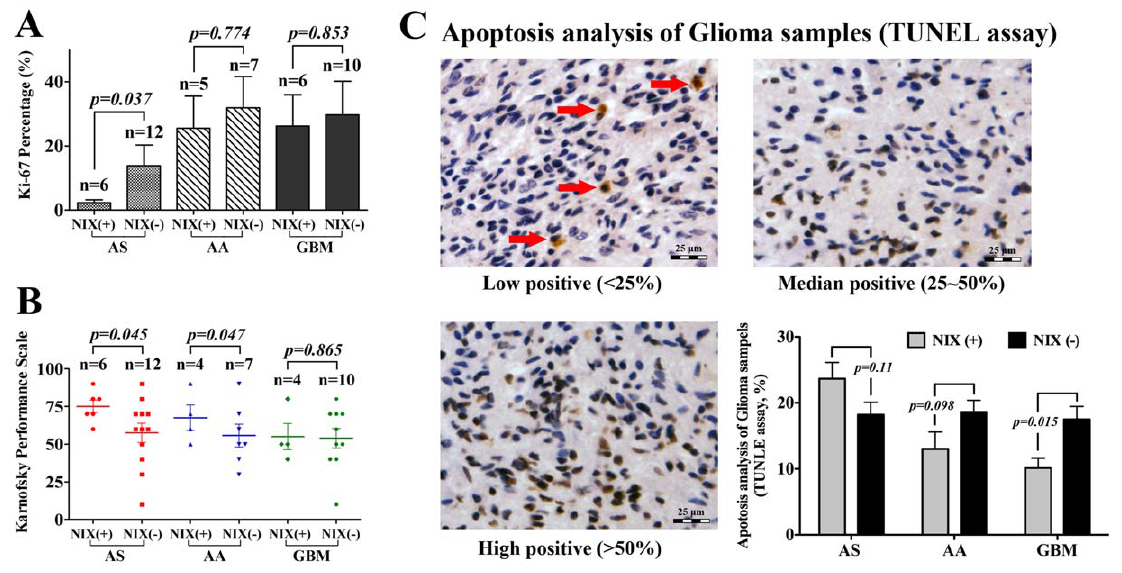
Figure 4. The influence of Nix protein on the behavior and prognosis of glioma patients. ( A ) In the 18 cases of astrocytoma, a high Ki-67 index indicated a more invasive ability in the Nix ( 2 ) cases ( p=0.037 ). ( B ) The KPS score showed that significant differences were found between Nix ( + ) and Nix ( 2 ) cases in astrocytoma ( p=0.045 ) and AA ( p=0.047 ). ( C ) Apoptosis analysis in 42 cases of clinical glioma samples by TUNEL assay, the result indicated that more severe tissue apoptosis happened in Nix ( 2 ) than Nix ( + ) GBM cases ( p =0.015). The same tendency was also displayed in AA samples, but not in AS groups, although the statistic significance was negative ( p =0.11 and 0.098).